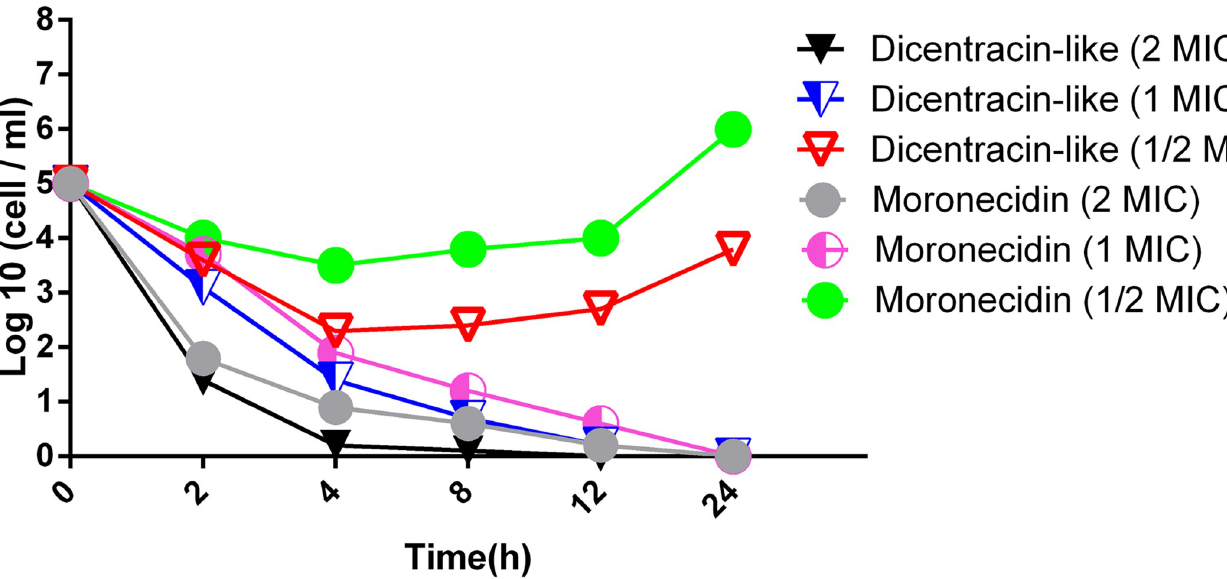
Fig 2. Effects of dicentracin-like and moronecidin on the viability of A . baumannii (clinical isolate). All data represent mean of two independent experiments.